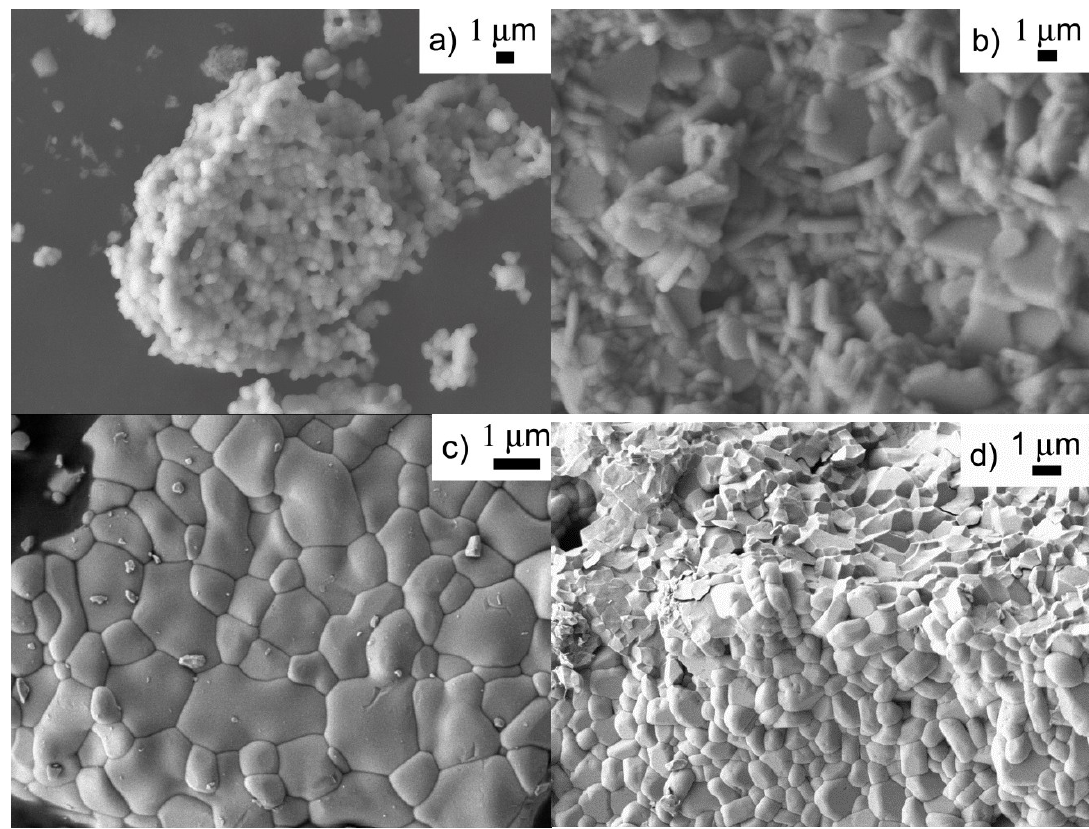
Figure 5. SEM images of samples prepared in: ( a ) CH 3 CN at 150 °C; ( b ) CH 3 CN at 170 °C for 7 days; ( c ) CHCl 3 at 170 °C; and ( d ) CHCl 3 at 110 °C. All images